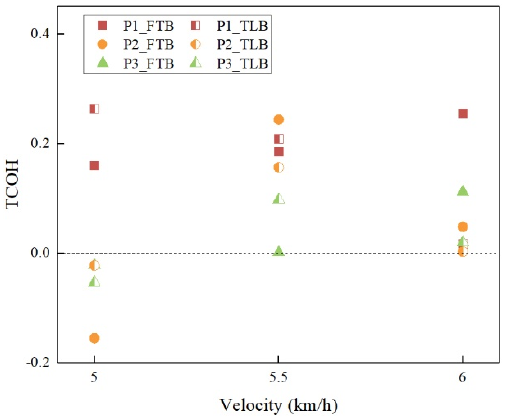
Figure 7. TCOH of three participants under three velocities. P1 represents the participant 1. FTB represents the FTB condition. TLB represents the TLB condition.